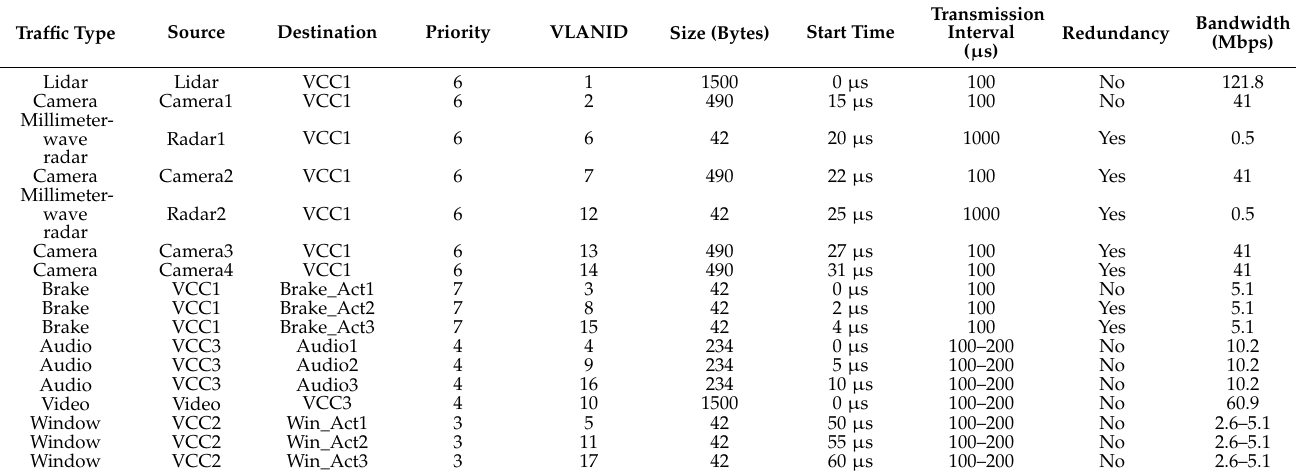
Table 6. Whole traffic characteristics in this TSN network.